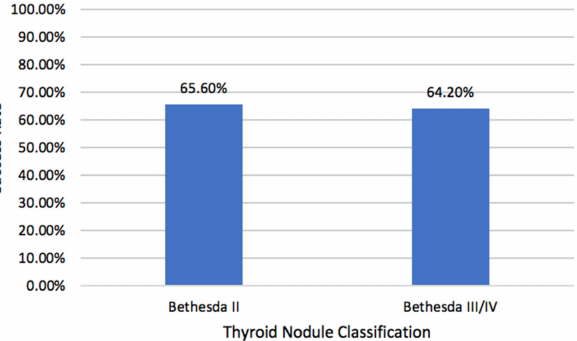
Figure 1. Success rates of benign and indeterminate thyroid nodules treated by RFA. Success was a volume reduction rate of ≥